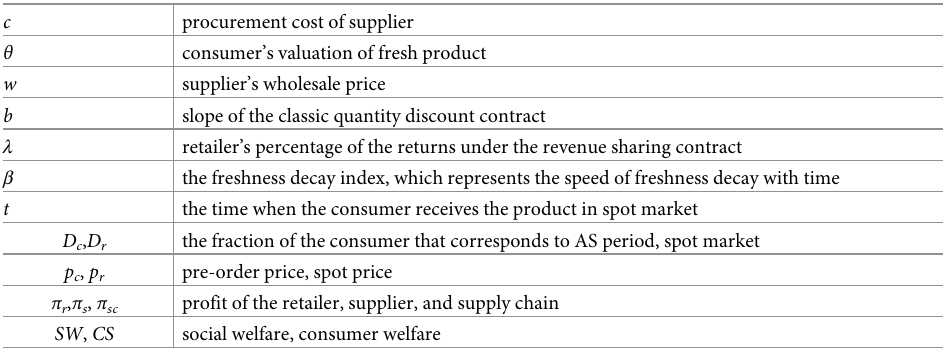
Table 1. Decision variables and